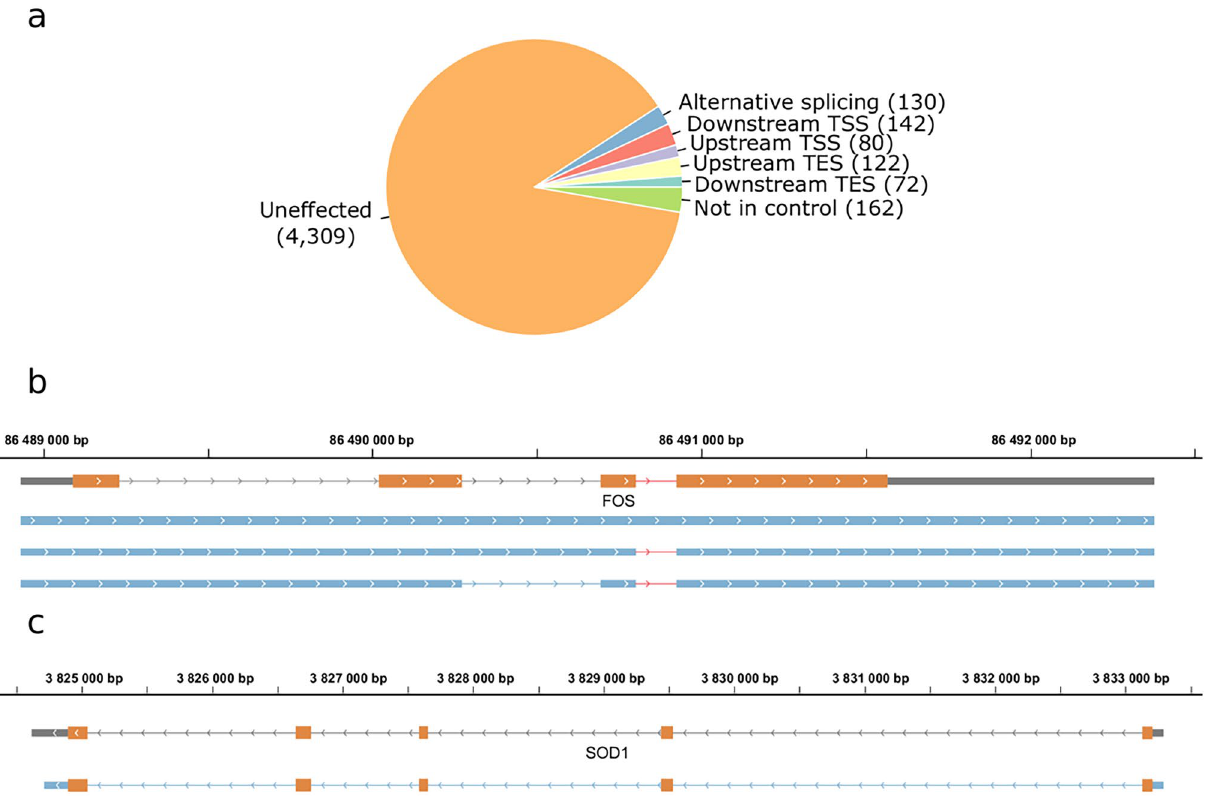
Figure 2. The effect of viral infection on the transcript isoforms of host cells. ( a ) A total of 546 transcript isoforms were detected with at least ten reads in the datasets of transcripts derived from infected bovine cells compared to the transcripts present in the mock dataset. ( b ) Gray rectangles represent previously detected transcript isoforms. The blue rectangles represent a novel non-spliced and two new splice variants of the FOS transcript. Introns are represented by lines between rectangles. The intron which is responsible for the increased degradation rate of FOS is shown in red. Orange rectangles represent the ORF. ( c ) The blue rectangles represent the novel TES isoform of SOD1, the lines represent introns, and orange rectangles illustrate the ORF. A SOD1 isoform with an upstream TES detected during the infection but not in the mock samples. Panel ( a ) was